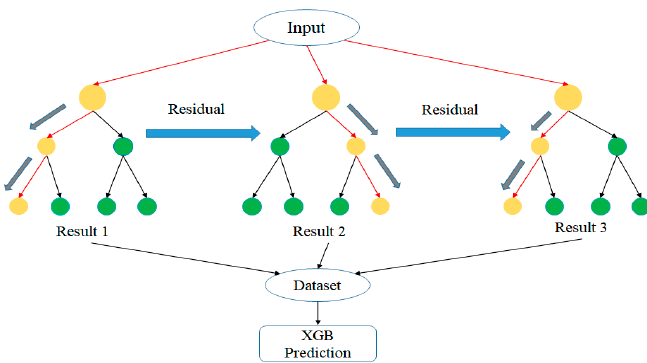
Figure 6. Conceptual representation of the XGBoost algorithm.